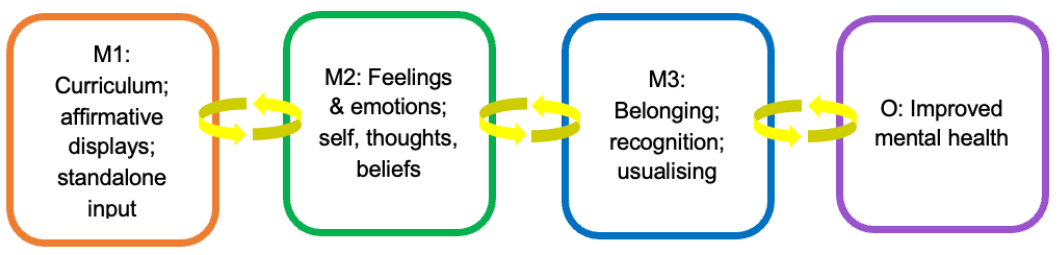
Figure 2. Interventions that promote LGBTQ+ visibility.